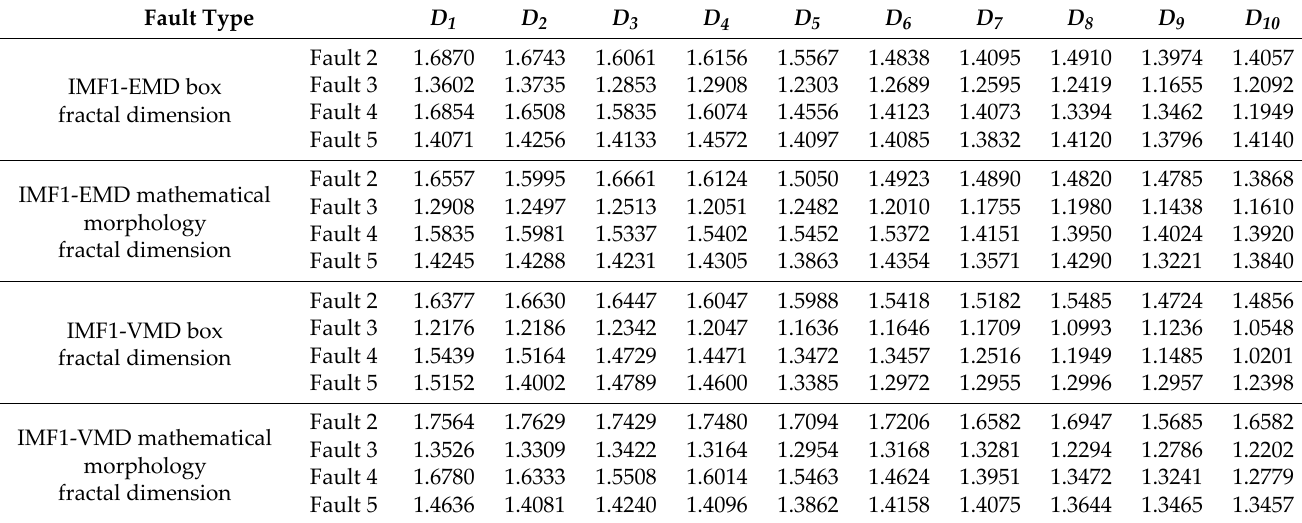
Figure 14. IMF1‑VMD mathematical morphology fractal dimension map. Table 2. Characteristic sample of the fault signal analysis